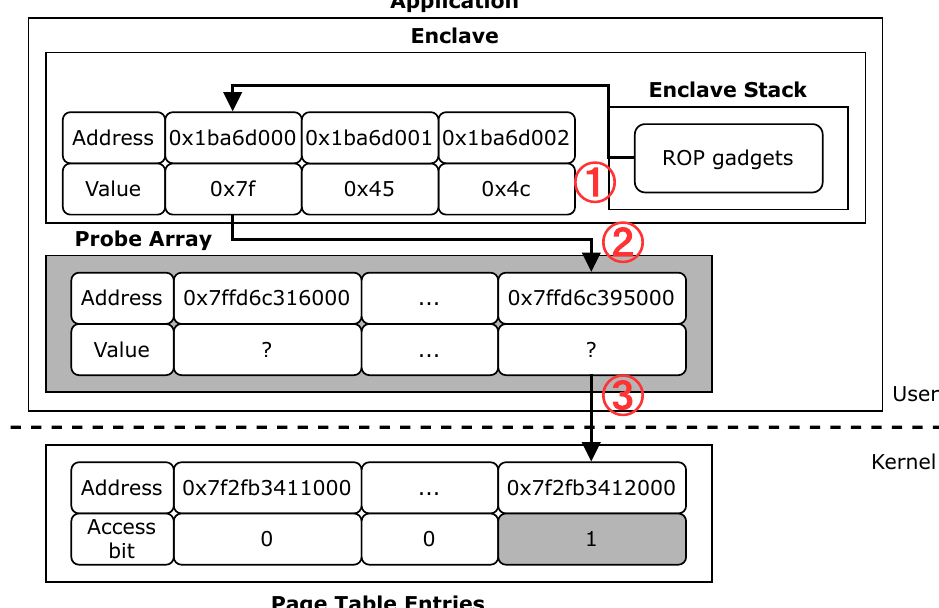
Figure 5. Flow of access bit